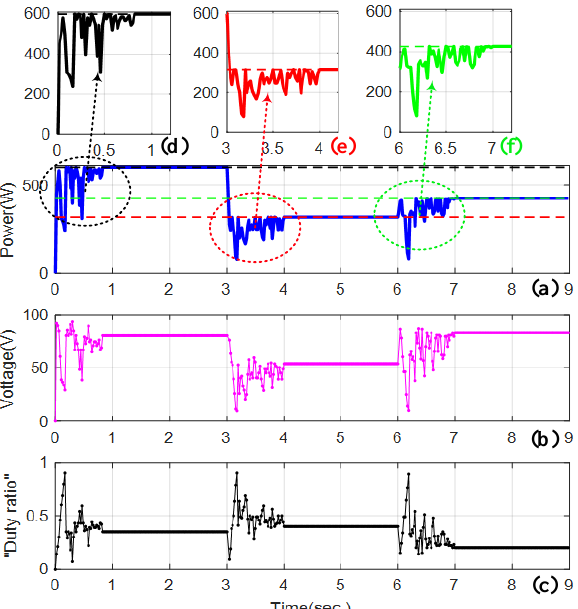
Figure 7. Results of the PSO method for three serial panels. ( a ) PV power, ( b ) PV voltage, ( c ) duty ratio, and ( d – f ) transient trajectories for situations 1 – 3, respectively. (Black --, red --, green --: global maximum values of situations 1 – 3).